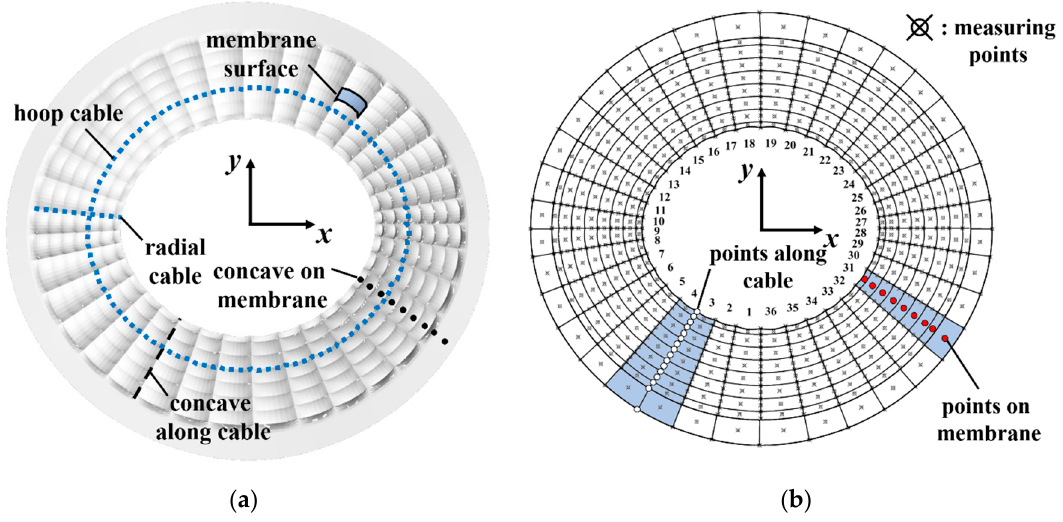
Figure 6. Arrangement of measuring points for snow depth: ( a ) roof form; ( b ) arrangement of measuring